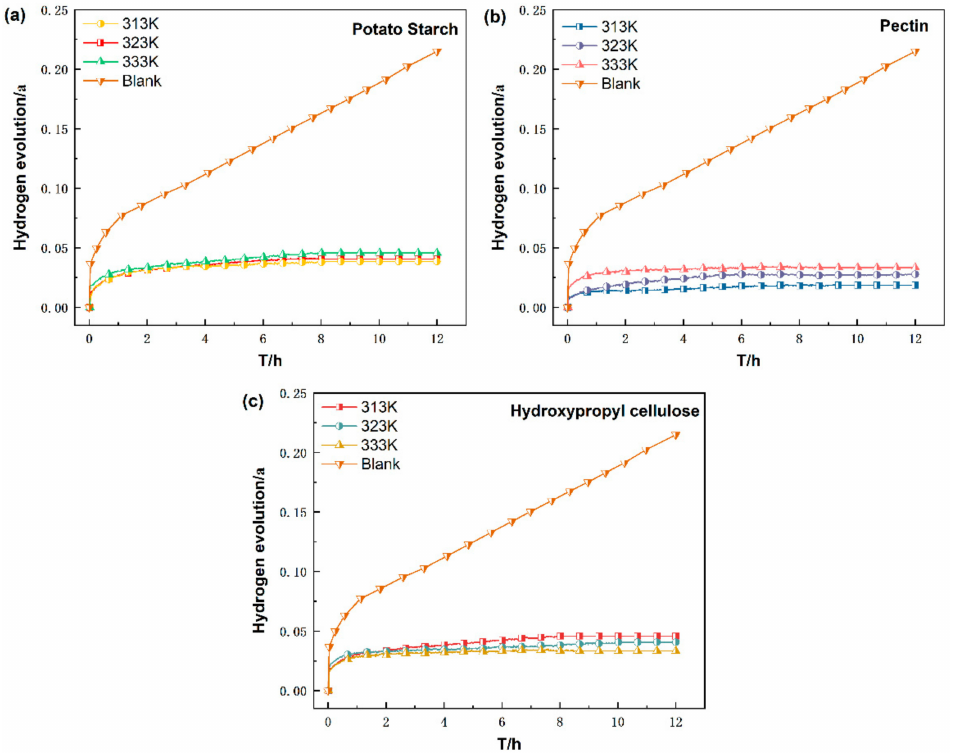
Figure 4. Hydrogen evolution curves of Al alloy dust in ( a ) PS, ( b ) PE, ( c ) HC inerting agent solutions under different